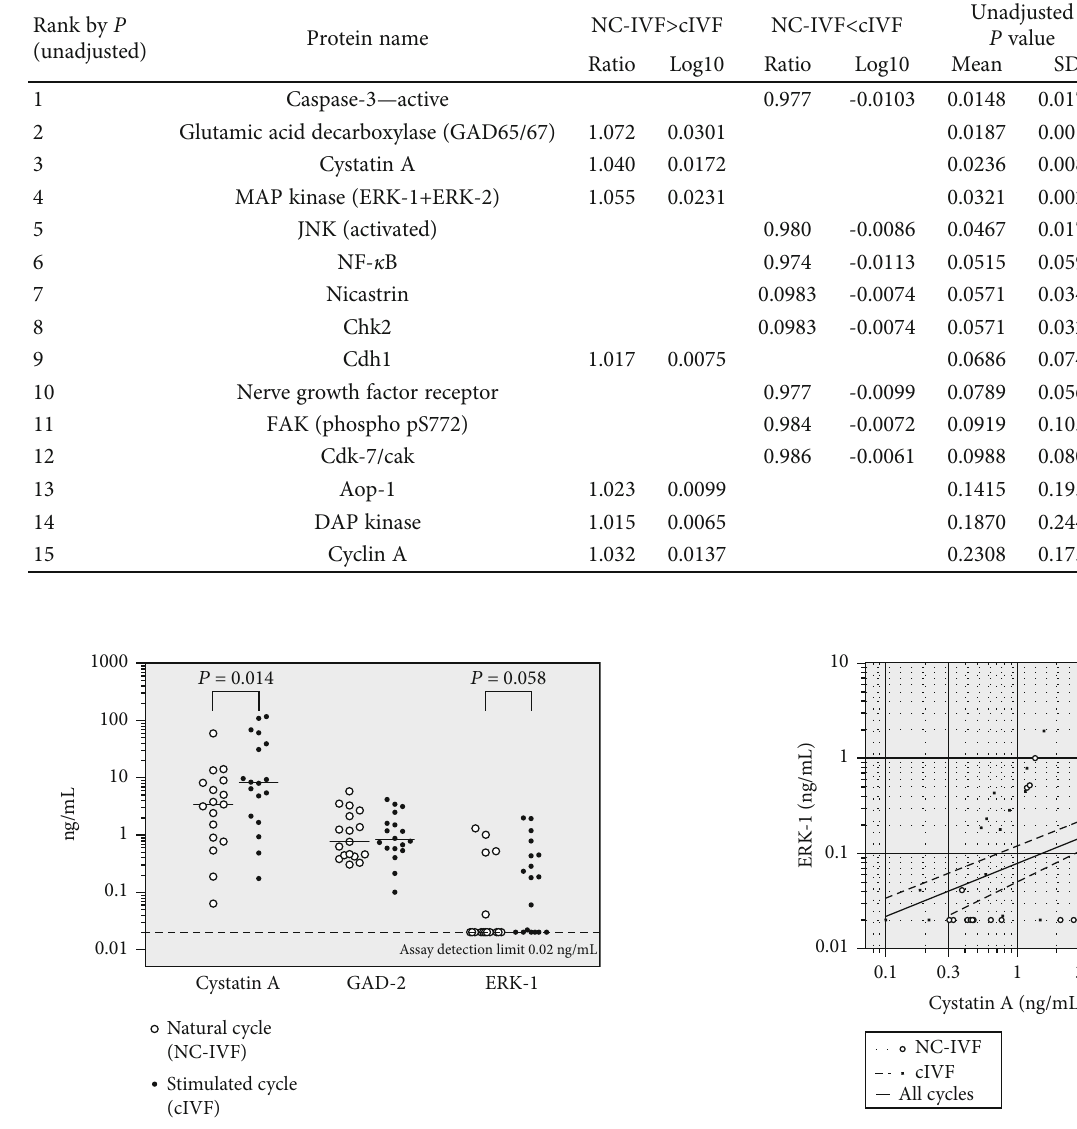
Figure 2: Correlation between the follicular fl uid levels of MAP kinase ERK-1 and Cystatin A, as determined by ELISA, in all available samples. Open circles, NC-IVF. Closed circles, cIVF. Please note the double logarithmic scale. Regression lines are shown for the two stimulation protocols as well for the combined group. For P values, see